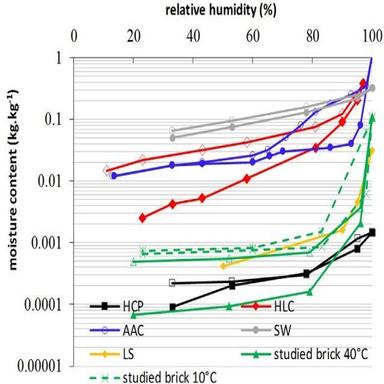
Main sorption isotherms of different materials used in the building sector: hemp –lime concrete (HLC), spruce wood (SW) , hardened cement paste (HCP), autoclaved aerated concrete (AAC) and limestone (LS)